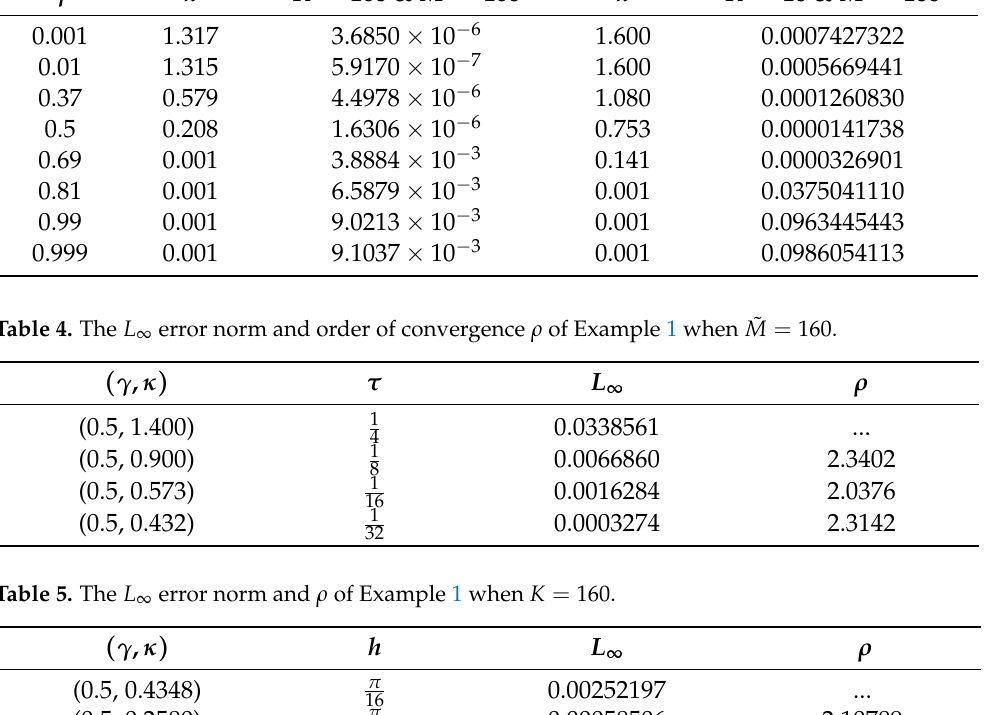
Table 3. Error analysis for Example 1 when τ = 1